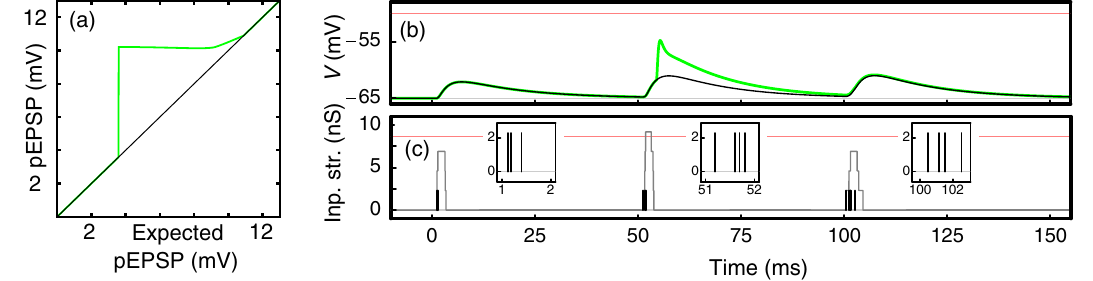
FIG. 1. Example dynamics of a conductance-based, leaky integrate-and-fire neuron with dendritic spike generation. (The neuron is initially at resting membrane potential V rest ¼ (cid:1) 65 mV , there are no external inputs, and I 0 ¼ 0 .) Panel (a) shows the pEPSP after a stimulation versus the expected pEPSP, i.e., the pEPSP for a neuron without dendritic spike generation. For inputs corresponding to a pEPSP larger than about 3 : 8 mV , a dendritic spike is generated which leads to a higher depolarization than expected from additive integration. Panel (b) shows the time course of the membrane potential of a neuron with (green) and without (black) nonlinear dendritic interaction in response to different excitatory inputs sequences. (The red horizontal line indicates the somatic spike threshold). Panel ð t Þ of excitatory inputs (c) shows the input sequences (black lines, strength: g ex ¼ 2 : 3 nS ; close-ups given in insets) and the sum g l; (cid:2) t received within the dendritic integration window [ t (cid:1) (cid:2) t , t ] (gray lines); cf. Eq. (9). At the first spike arrival around t ¼ 1 ms , three ð t Þ reaches 6.9 nS. The sum is smaller than the dendritic threshold g (cid:1) ¼ 8 : 65 nS [red inputs are received within (cid:2) t such that g l; (cid:2) t horizontal line in (c)], so no dendritic spike is generated and there is no difference between the membrane potential for a neuron with ð t Þ exceeds the dendritic and without a mechanism for dendritic spike generation. Around t ¼ 50 ms , four spikes arrive within (cid:2) t , g l; (cid:2) t threshold, and a dendritic spike is generated. Around t ¼ 100 ms , four spikes arrive at the neuron, but the temporal difference between ð t Þ does not exceed the dendritic threshold and no dendritic the last and the first spike is slightly larger than (cid:2) t . Consequently, g l; (cid:2) t spike is